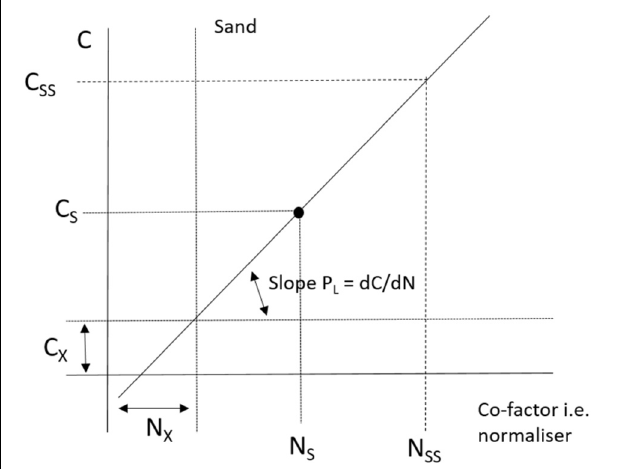
FIGURE 3 | Regression between the contaminant C and the cofactor N (redrafted from Smedes et al., 1997, with permission), with C S and N S the measured contaminant and co-factor content, C SS and N SS the standard reference contaminant and co-factor content, and C x and N x the contaminant and co-factor content in pure